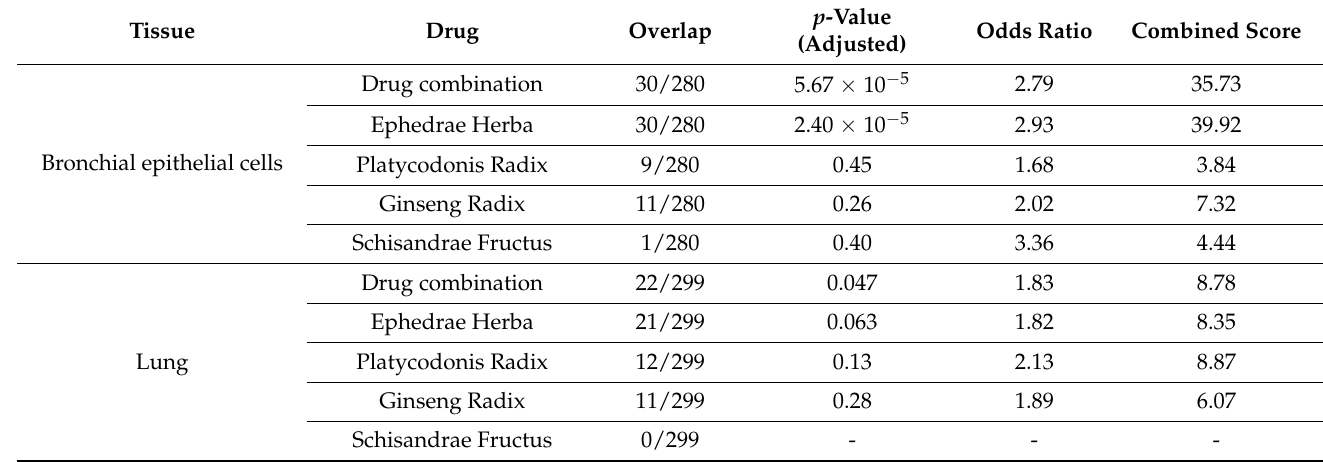
Table 4. Enrichment analysis of the impact of each drug on the tissue types related to COVID-19.